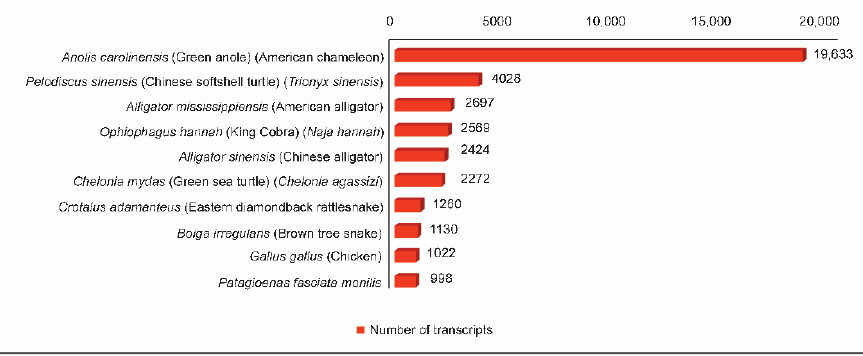
Figure 1. BLASTX similarity score distribution of transcripts.